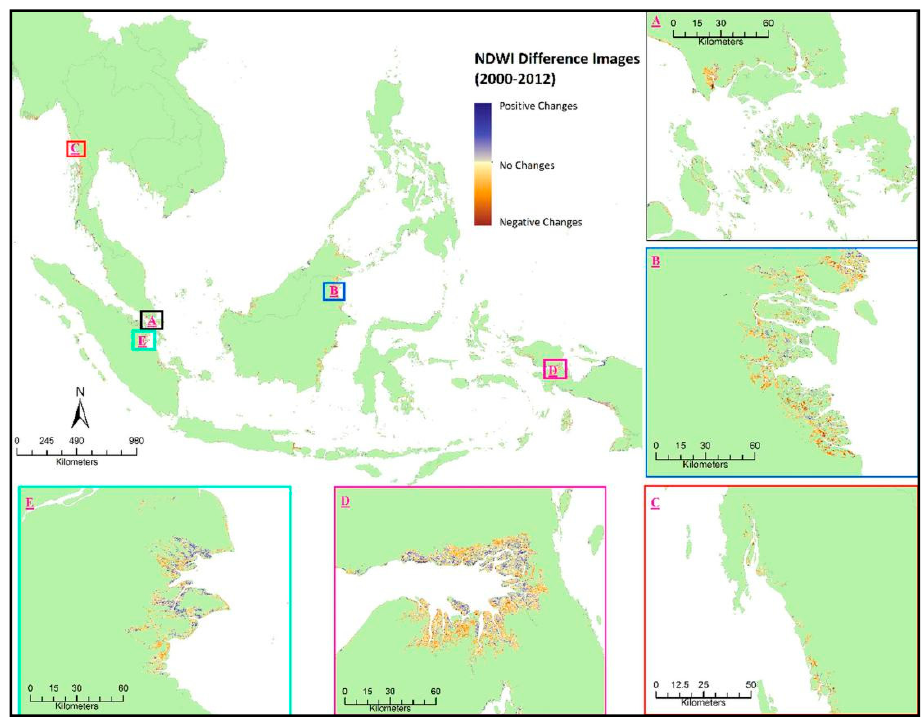
Figure 4. NDWI change between 2000 and 2012 in mangrove area. ( A ) NDWI decrease in Singapore. ( B ) NDWI decrease in North Kalimantan. ( C ) NDWI decrease in West Thailand. ( D ) NDWI increase in West Papua. ( E ) NDWI increase in South Sumatra.